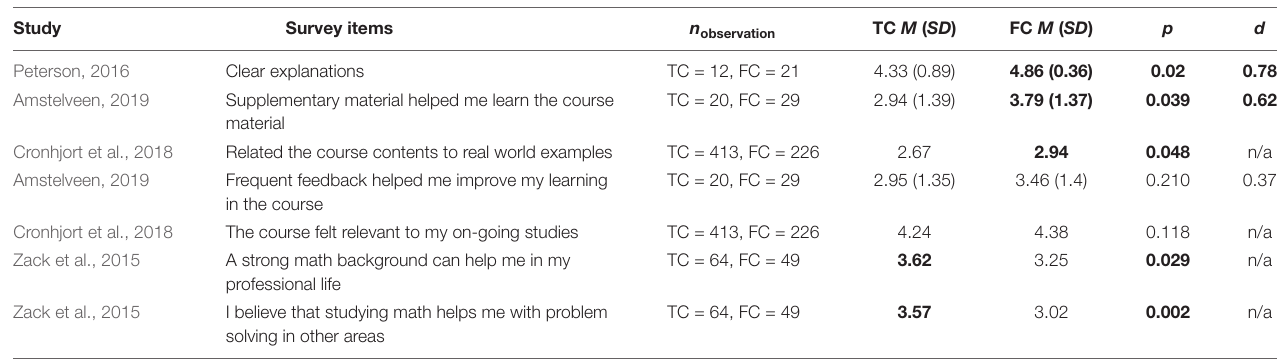
TABLE 8 | Survey results: Understanding of mathematics by effect size.